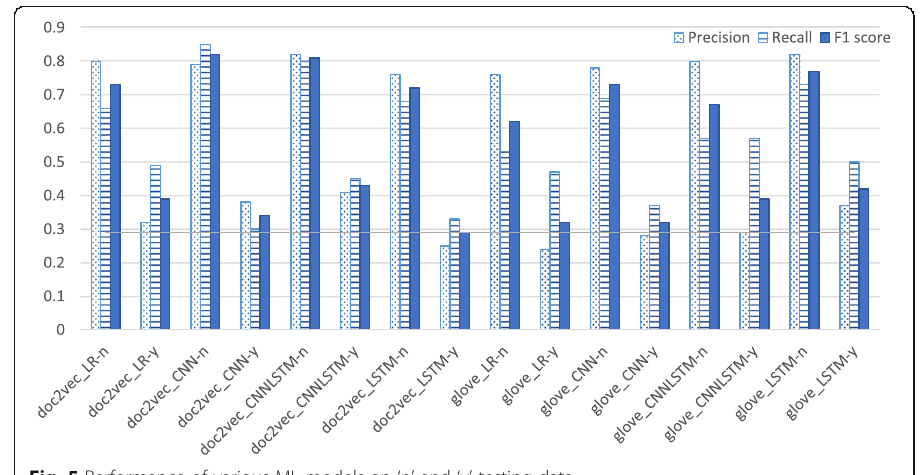
Fig. 5 Performance of various ML models on ‘ n ’ and ‘ y ’ testing data